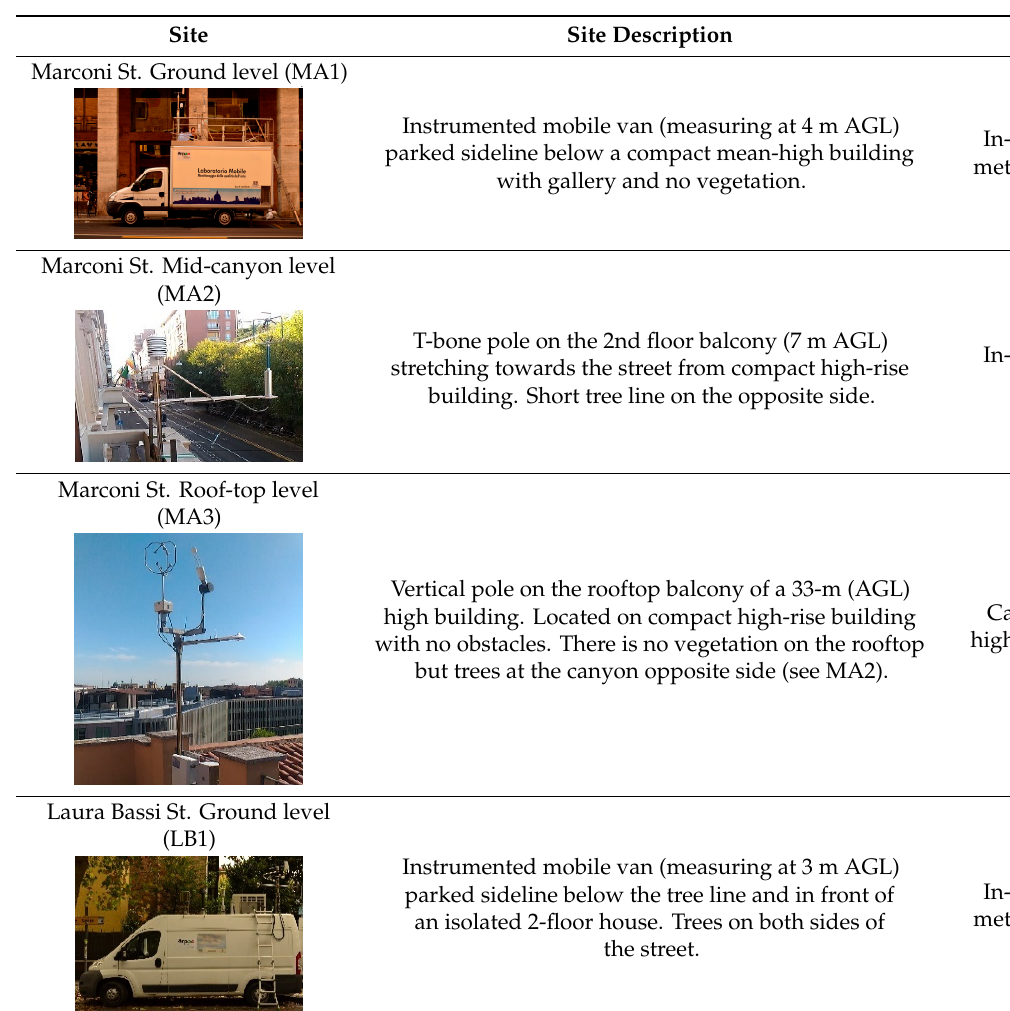
Table 1. Experimental setup and Table 1. Experimental setup and measurements. Table 1. Experimental setup and measurements. Table 1. Experimental setup and measurements. Table 1. Experimental setup and measurements.